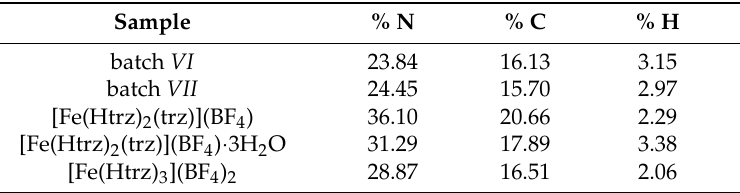
Table 3. Elemental analysis (CHN) for batches VI and VII with expected values for trials to get [Fe(Htrz) 2 (trz)](BF 4 ).